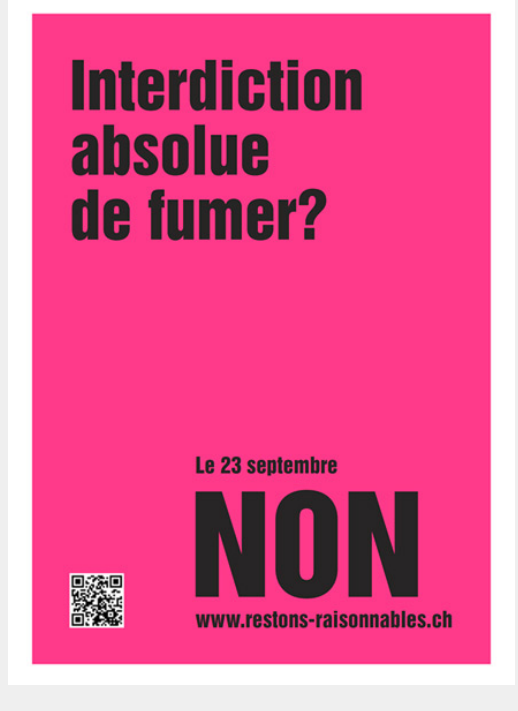
Main poster used by opponents to the initiative (French